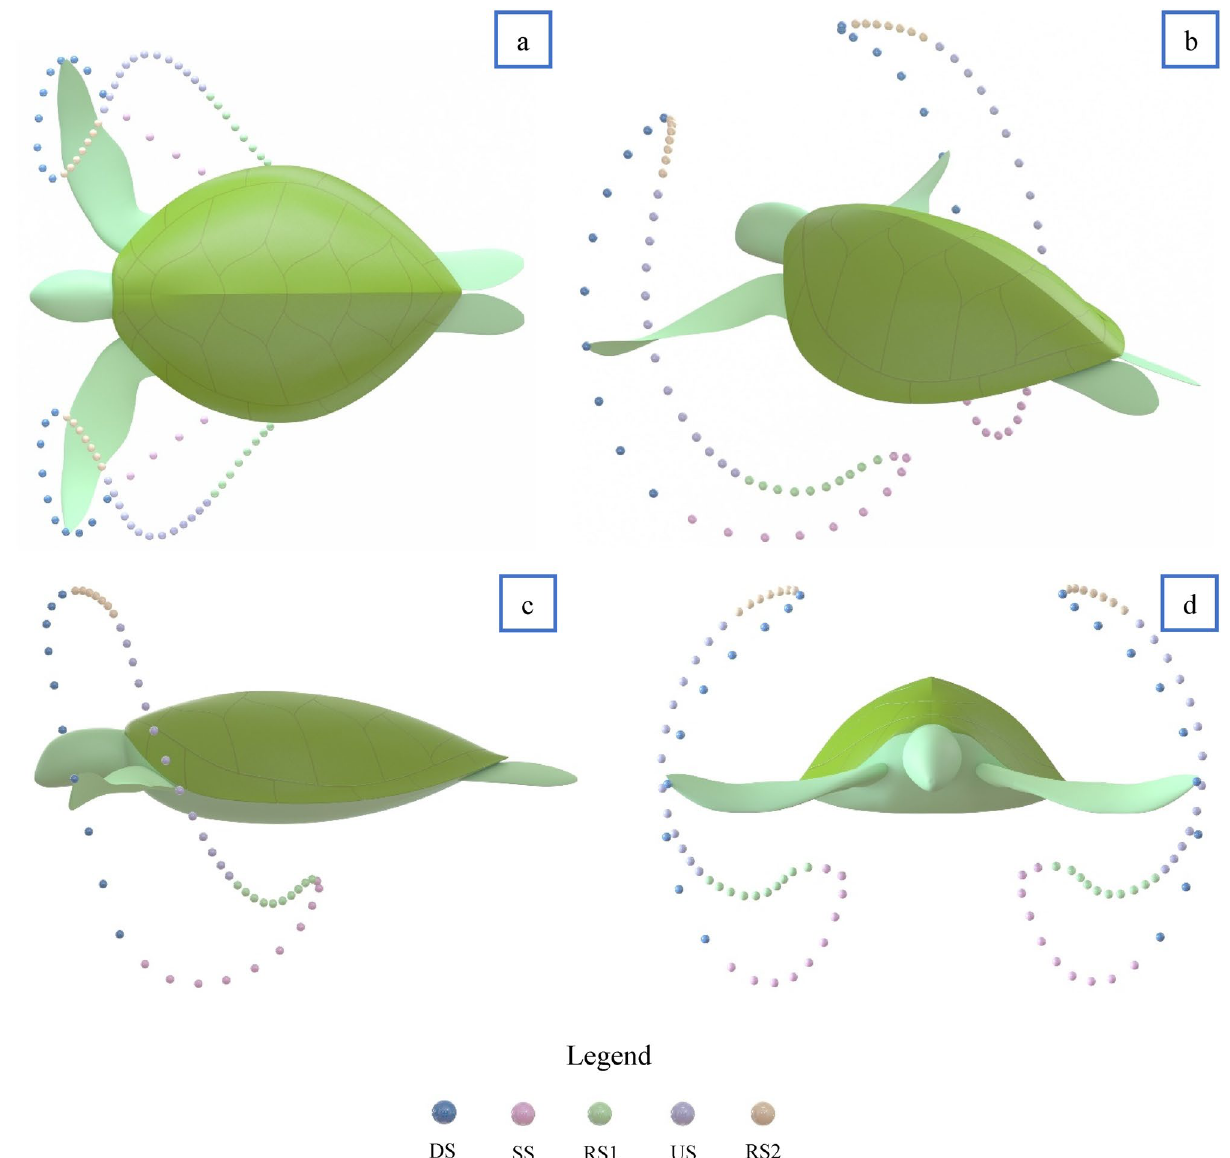
Figure 6. Complete 3D reconstruction of flipper tip motion from observational video. Data spheres represent 0.084 s time increments. When viewing from the Sagittal plane, the five stages can be characterised as follows: The downstroke (DS) is characterised by the fastest flipper motion with a slight reward motion. Sweep stroke (SS) is characterised by substantial horizontal displacement towards the centre of the carapace. Recovery stroke one (RS1) is characterised by slow-moving and modest horizontal displacement to recover the flipper into position for the upstroke. The upstroke (US) is characterised by a slow, predominantly straight path with slight forward motion. And finally, recovery stroke two (RS2) is characterised by the slowest moving section of the stroke to ready the flipper for the fast-moving downstroke. ( a ) View from Coronal plane. ( b ) 3D View, ( c ) View from Sagittal plane. ( d ) View from Transverse